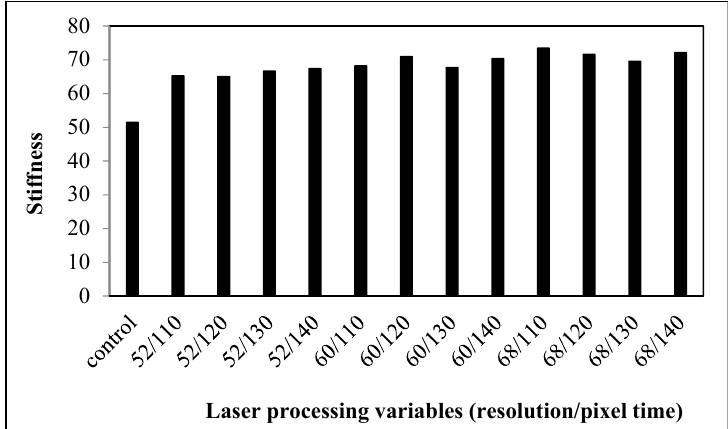
Figure 7. Relationship between laser processing variables and the stiffness of cotton/polyester blended fabric.